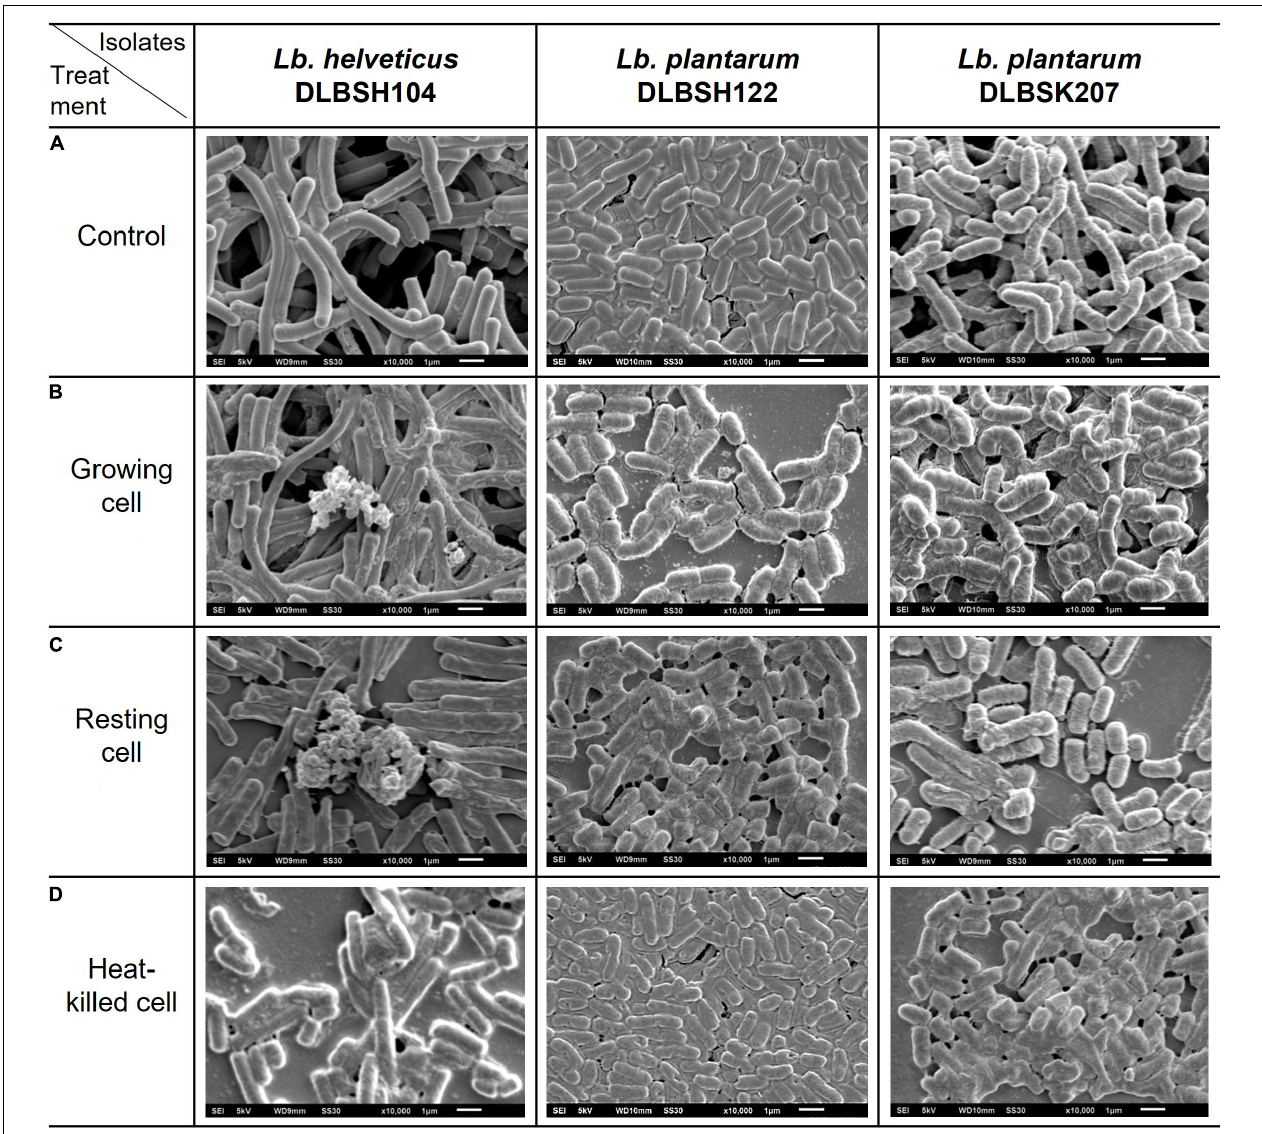
FIGURE 3 | Scanning electron micrograph of potential probiotics in media containing no cholesterol (A) and media containing cholesterol (B–D) after incubated at 37 ◦ C for 20